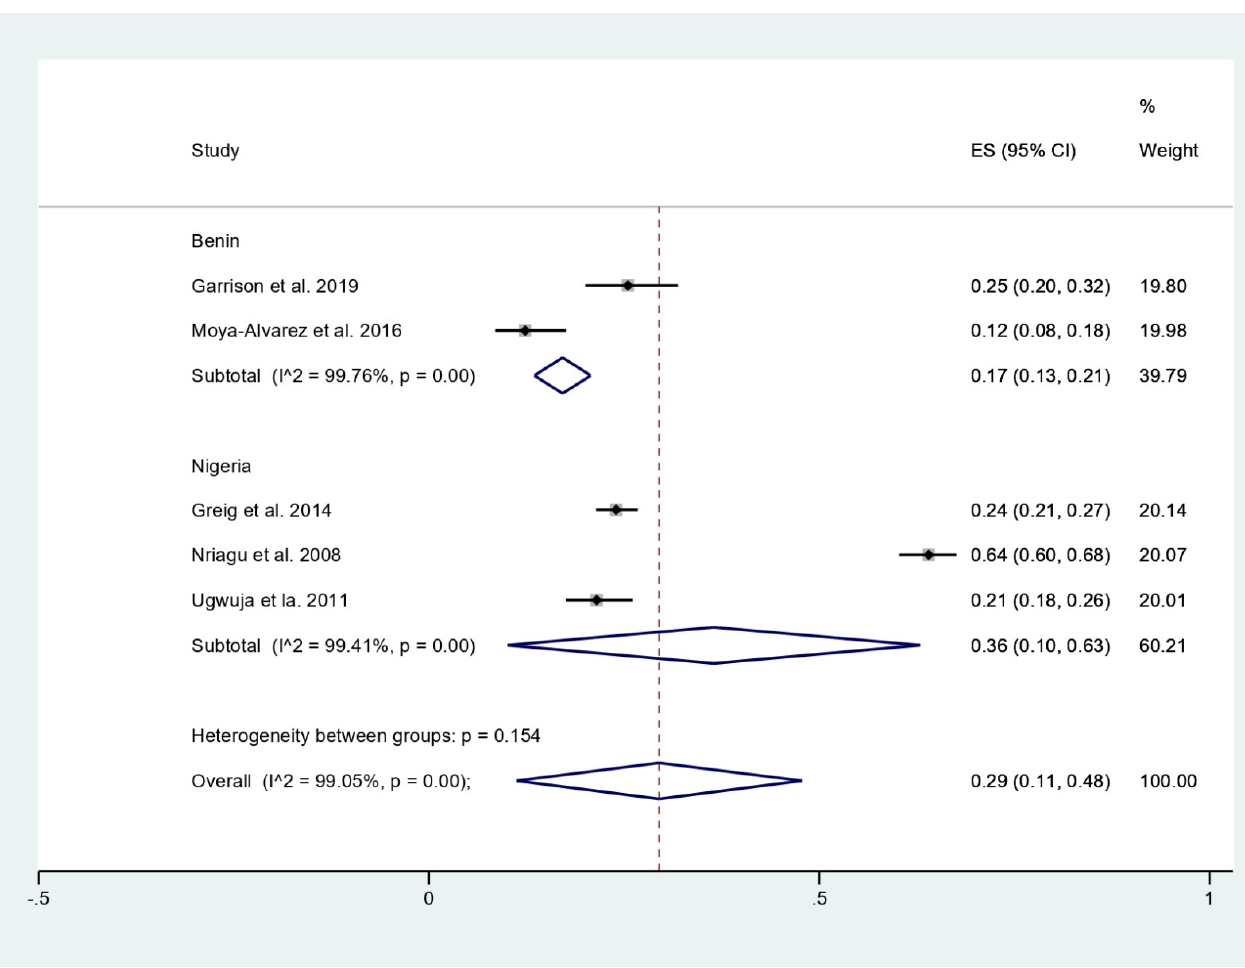
Figure 4. Pooled prevalence of malaria among participants by country. ES, effect size (prevalence of malaria); CI, confidence interval; black diamond symbol, point estimate; solid line in the middle of the graph at 0, zero effect size .